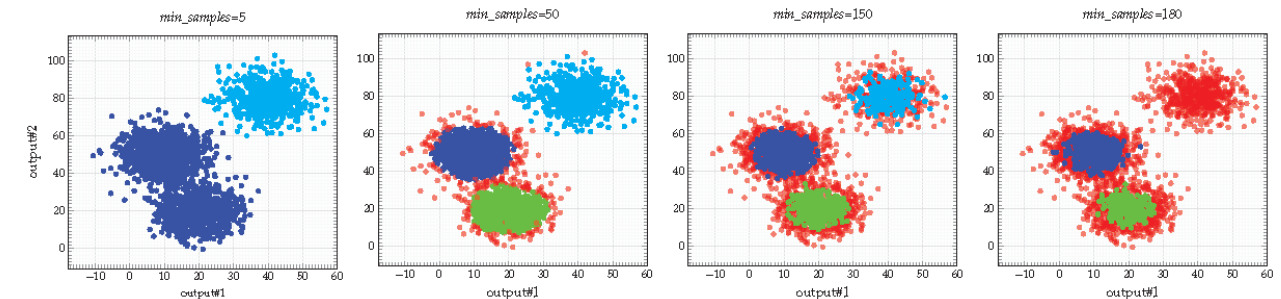
Figure 3. Example of clustering results for different values of min_samples (total obs = 2624). The larger the value of min_samples , the more conservative the clustering, i.e., clusters will be restricted to progressively more dense regions (outliers are depicted in red).